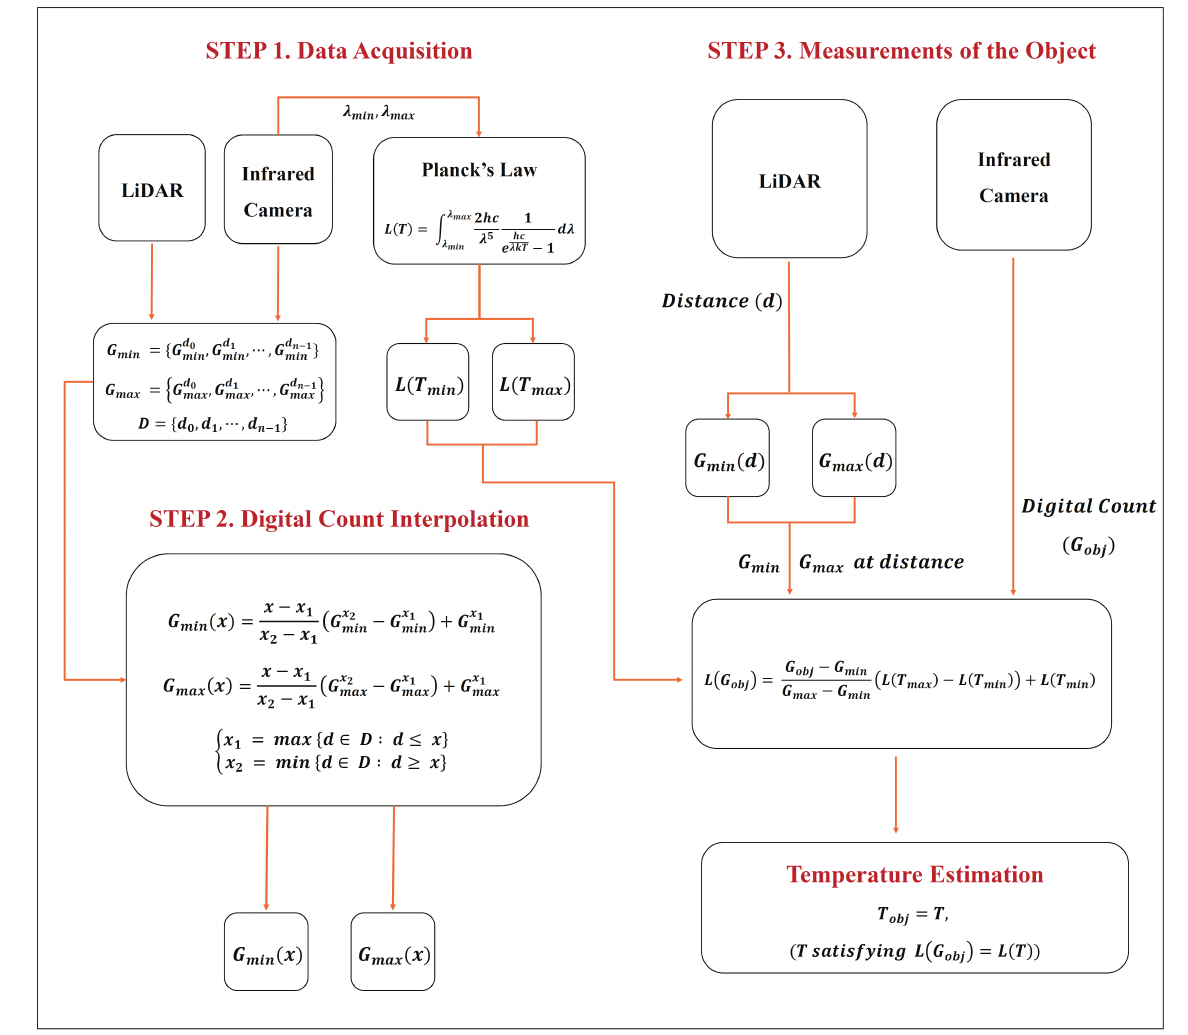
Figure 5. Overall process flow of the proposed